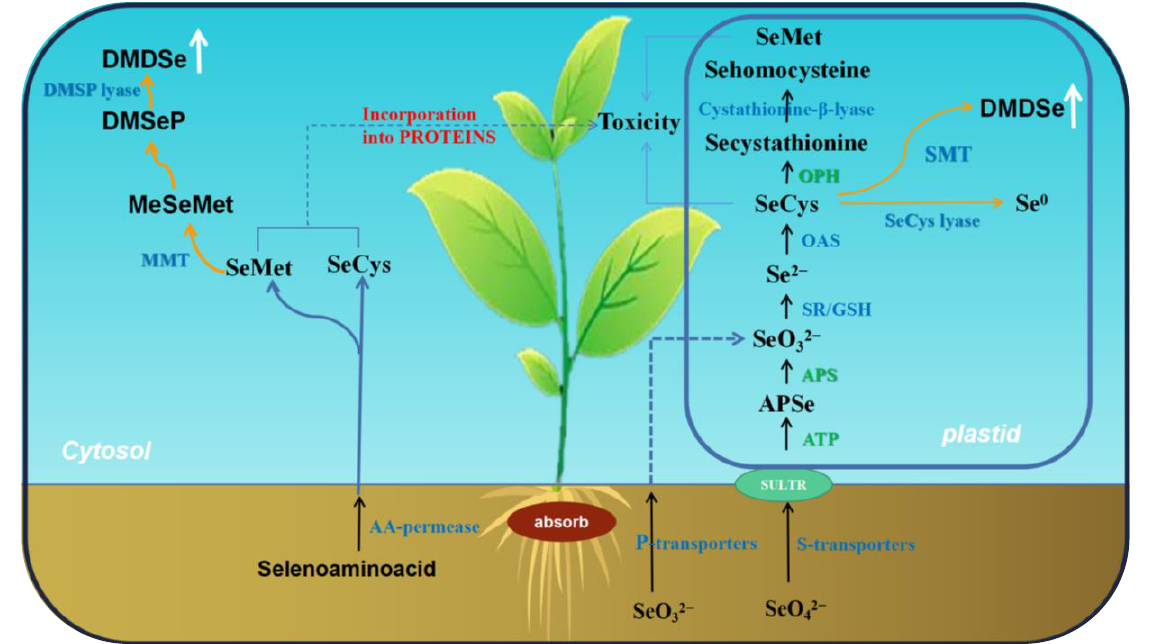
Figure 1. Schematic diagram of Se assimilation and metabolism in plant cells. SULTR, sulfate/selenate cotransporter; APSe, adenosine phosphoselenate; APS, adenosine phosphosulfate; SR, Sulfite Reductase; GSH, glutathione; SAT, serine acetyltransferase; OAS, O-acetylserine; (Se) Cys, (seleno)cysteine; OPH, O-phosphohomoserine; (Se)Met, (seleno) methionine; MMT, methylmethionine methyltransferase; DMSeP, dimethylselenoproprionate; DM(D)Se, dimethyl(di)selenide (volatile); SMT, selenocysteine methyltransferase.